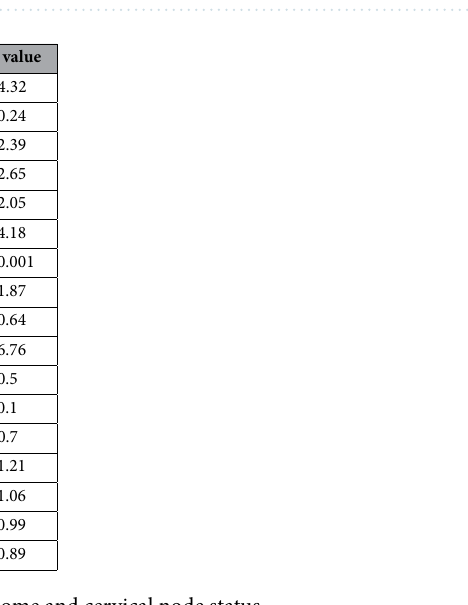
Table 4. Molecular markers associated with stage, outcome and cervical node